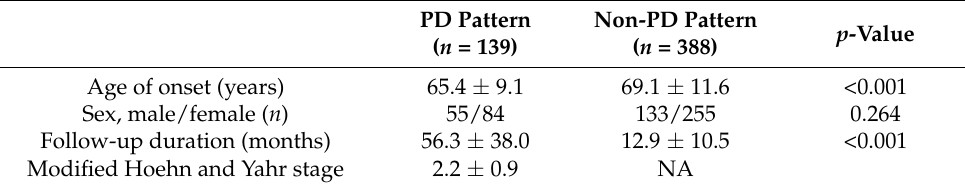
Table 2. Baseline characteristics of patients ( n = 527) undergoing medical imaging for the differential diagnosis of parkinsonism.